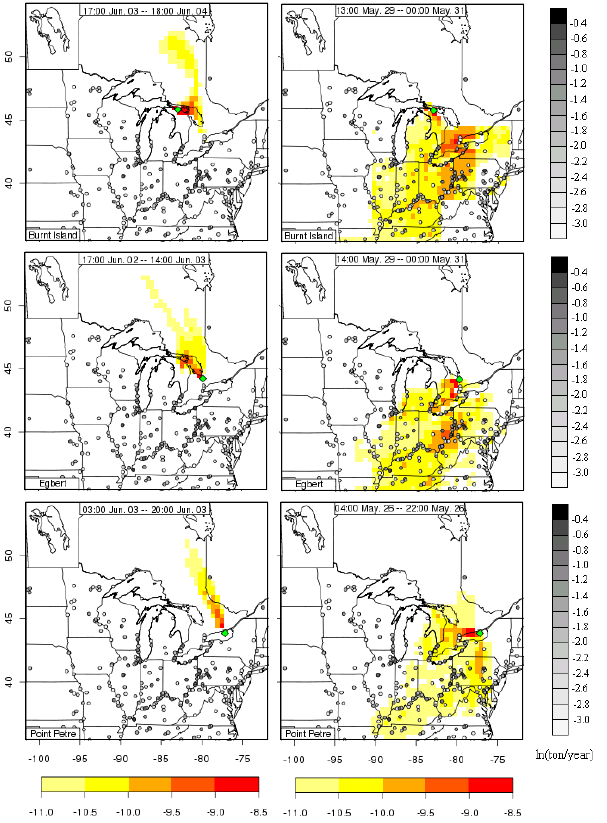
Fig. 9. Similar to Fig. 7: Source contributions [log 10 (ppm)] for the selected Hg plumes (right) and low episodes (left) in 20–29 July for Burnt Island (top), Egbert (middle) and Point Petre